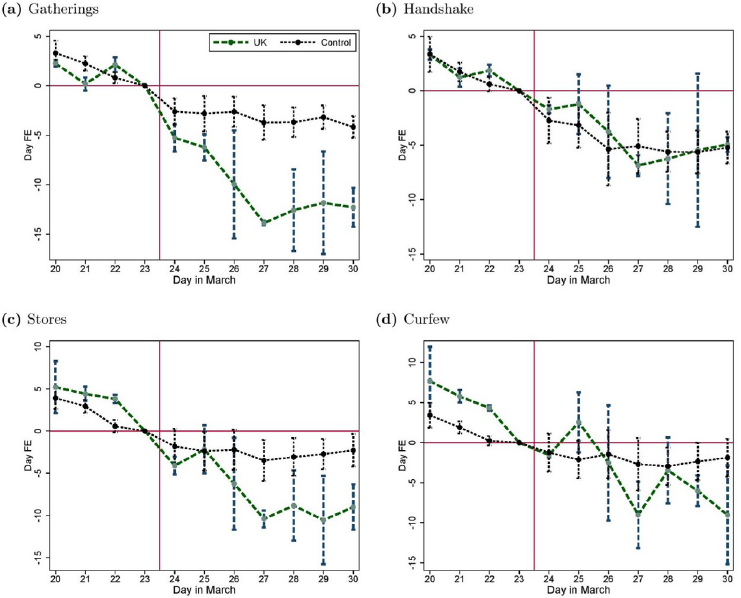
Fig 5. Time pattern of the misperceptions in the UK and the control group. The figure reports the day-fixed effects along with their 95% confidence intervals from separate regressions in the UK and in the control group of the misperception about (a) social gatherings, (b) handshaking, (c) stores closure and (d) a total curfew, controlling for country, age, gender, education, and income-fixed effects, as well as household composition. Standard errors are clustered at the country-gender